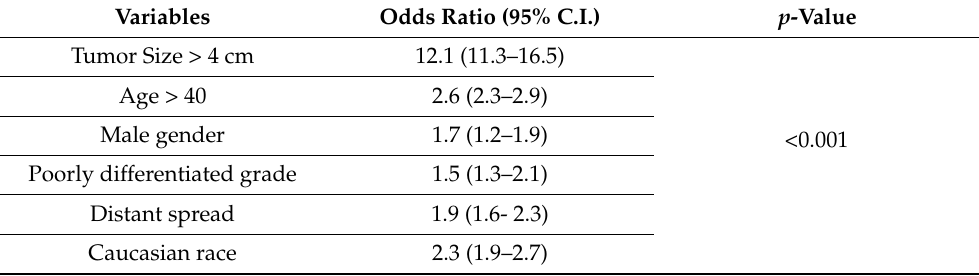
Table 8. Multivariate analysis of factors influencing mortality in patients with parathyroid cancer from the Surveillance, Epidemiology, and End Results (SEER) database